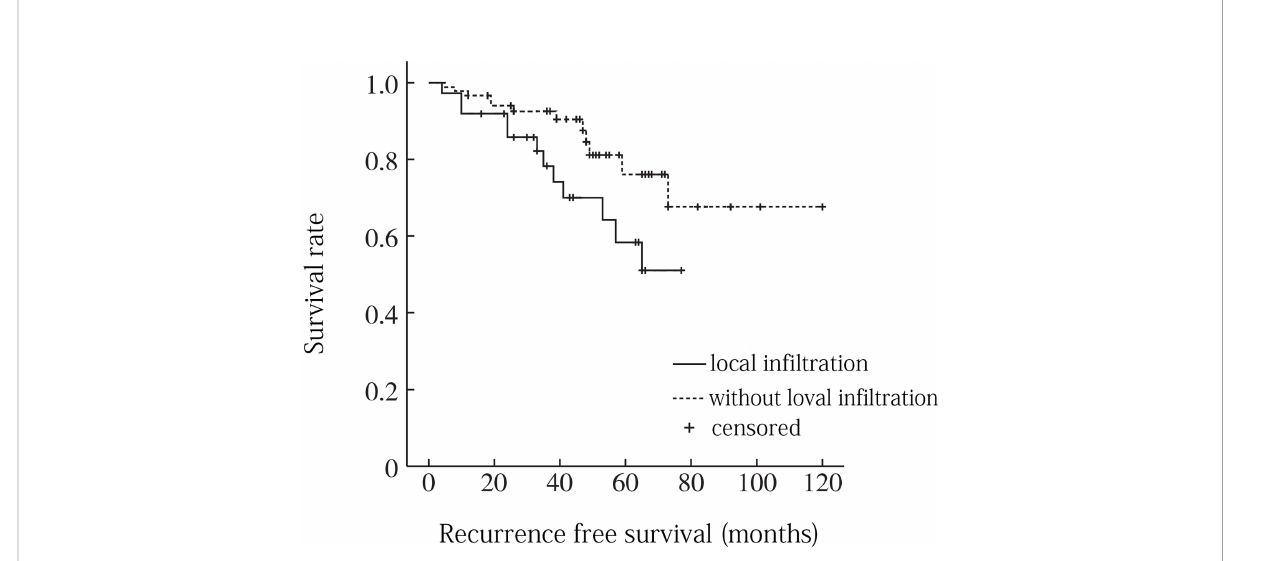
FIGURE 3 Recurrence free survival curve for sacrococcygeal chordoma with or without local in fi ltration .